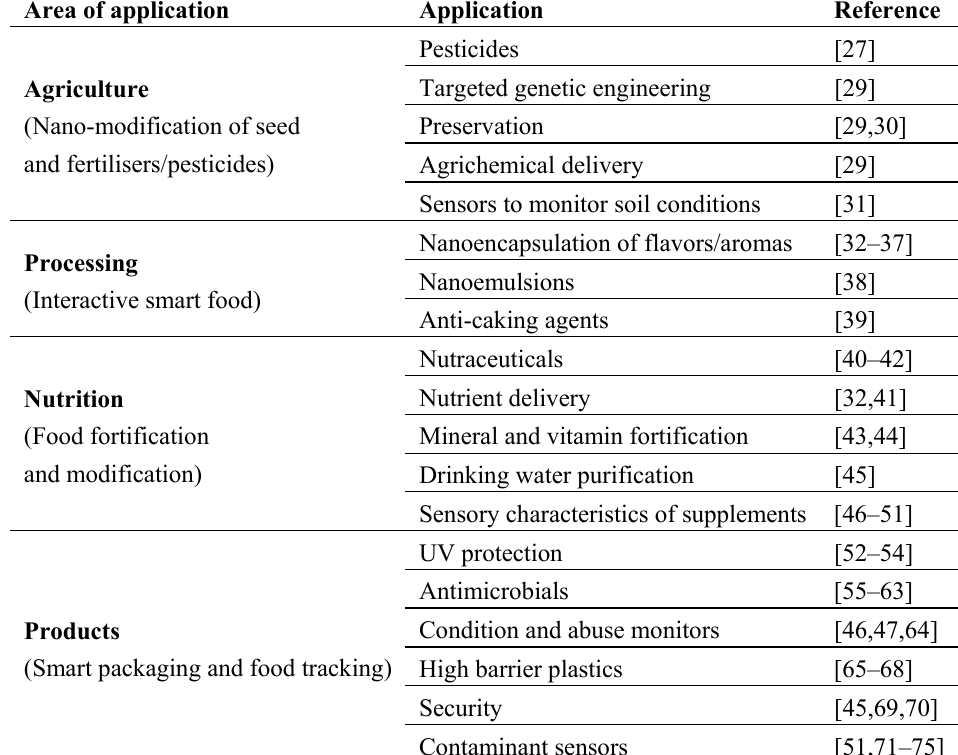
Table 1. (Potential) applications of nanotechnology in food